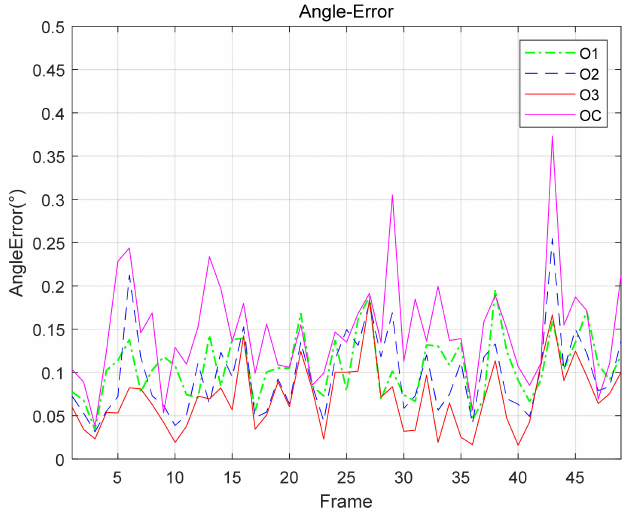
Figure 10. This is a figure of the angle error of the normal vector corresponding to the captured